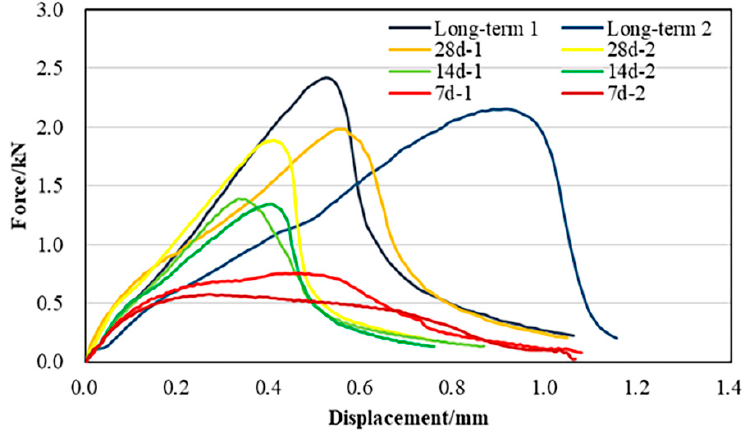
Figure 5. The load-displacement curve of CRME at different curing times.